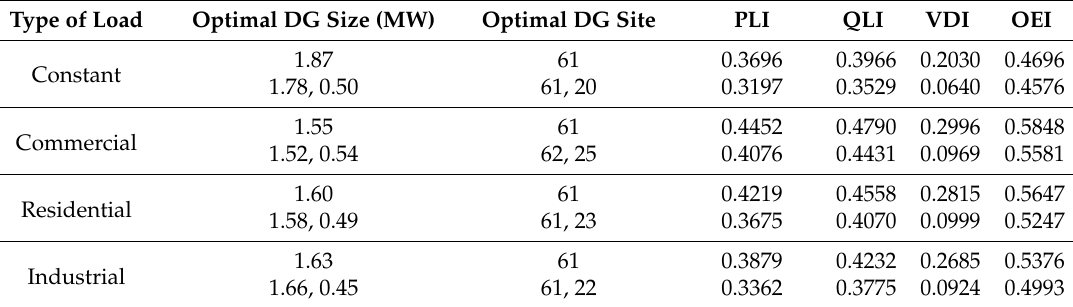
Table 7. Optimal size and site of DG for the placement of single DG and multiple DG and Indices values for multi-objective optimization (PLI and VDI).